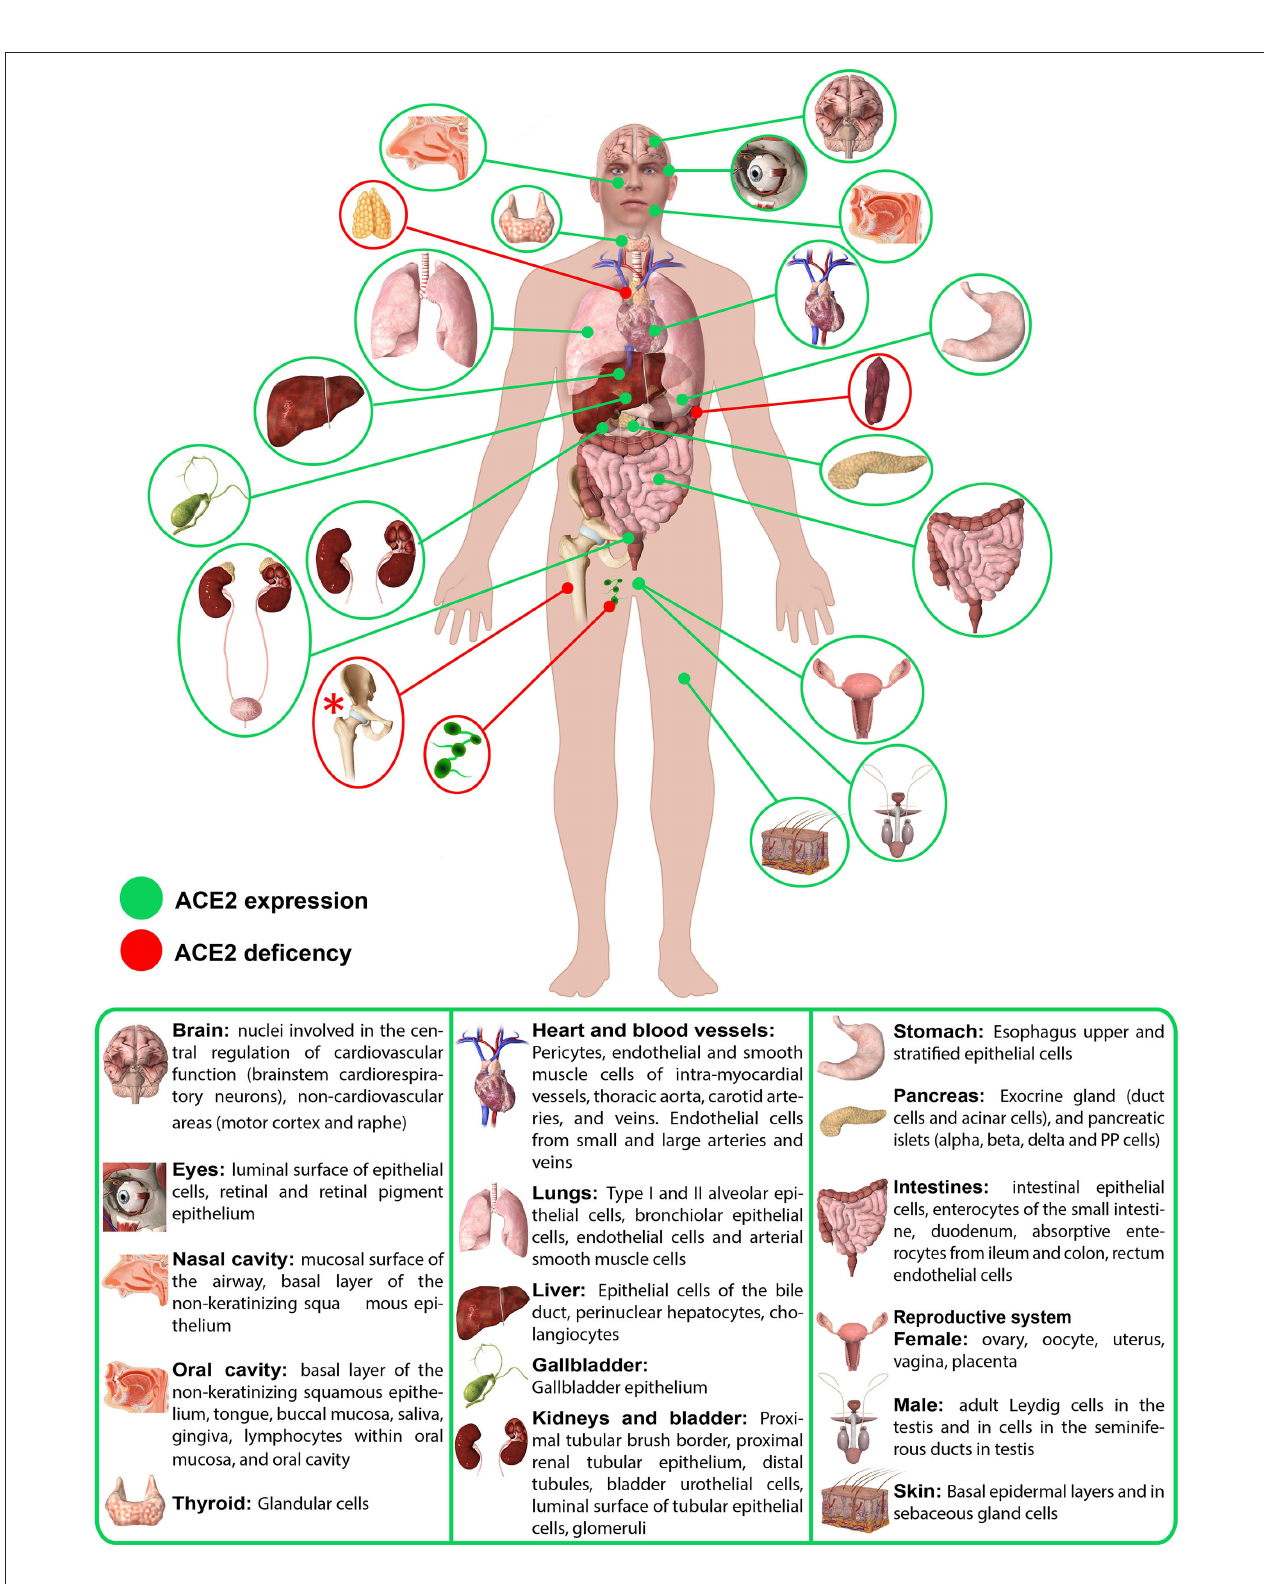
FIGURE 1 | Schematic representation of ACE2 expression in human organs. ACE2 mRNA is present in all organs (28). ACE2 protein expression is present in heart, kidney, testis, lung (type I and type II alveolar epithelial cells), nasal, and oral mucosa and nasopharynx (basal layer of the non-keratinizing squamous epithelium),